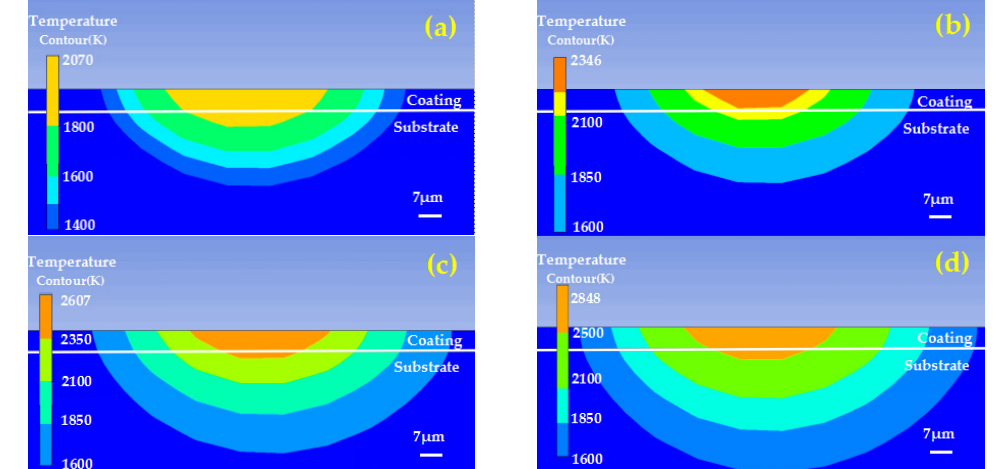
Figure 3. Sample No. 3 ( a ), No. 4 ( b ), No. 5 ( c ), No. 6 ( d ) of temperature nephogram for laser melting simulation.